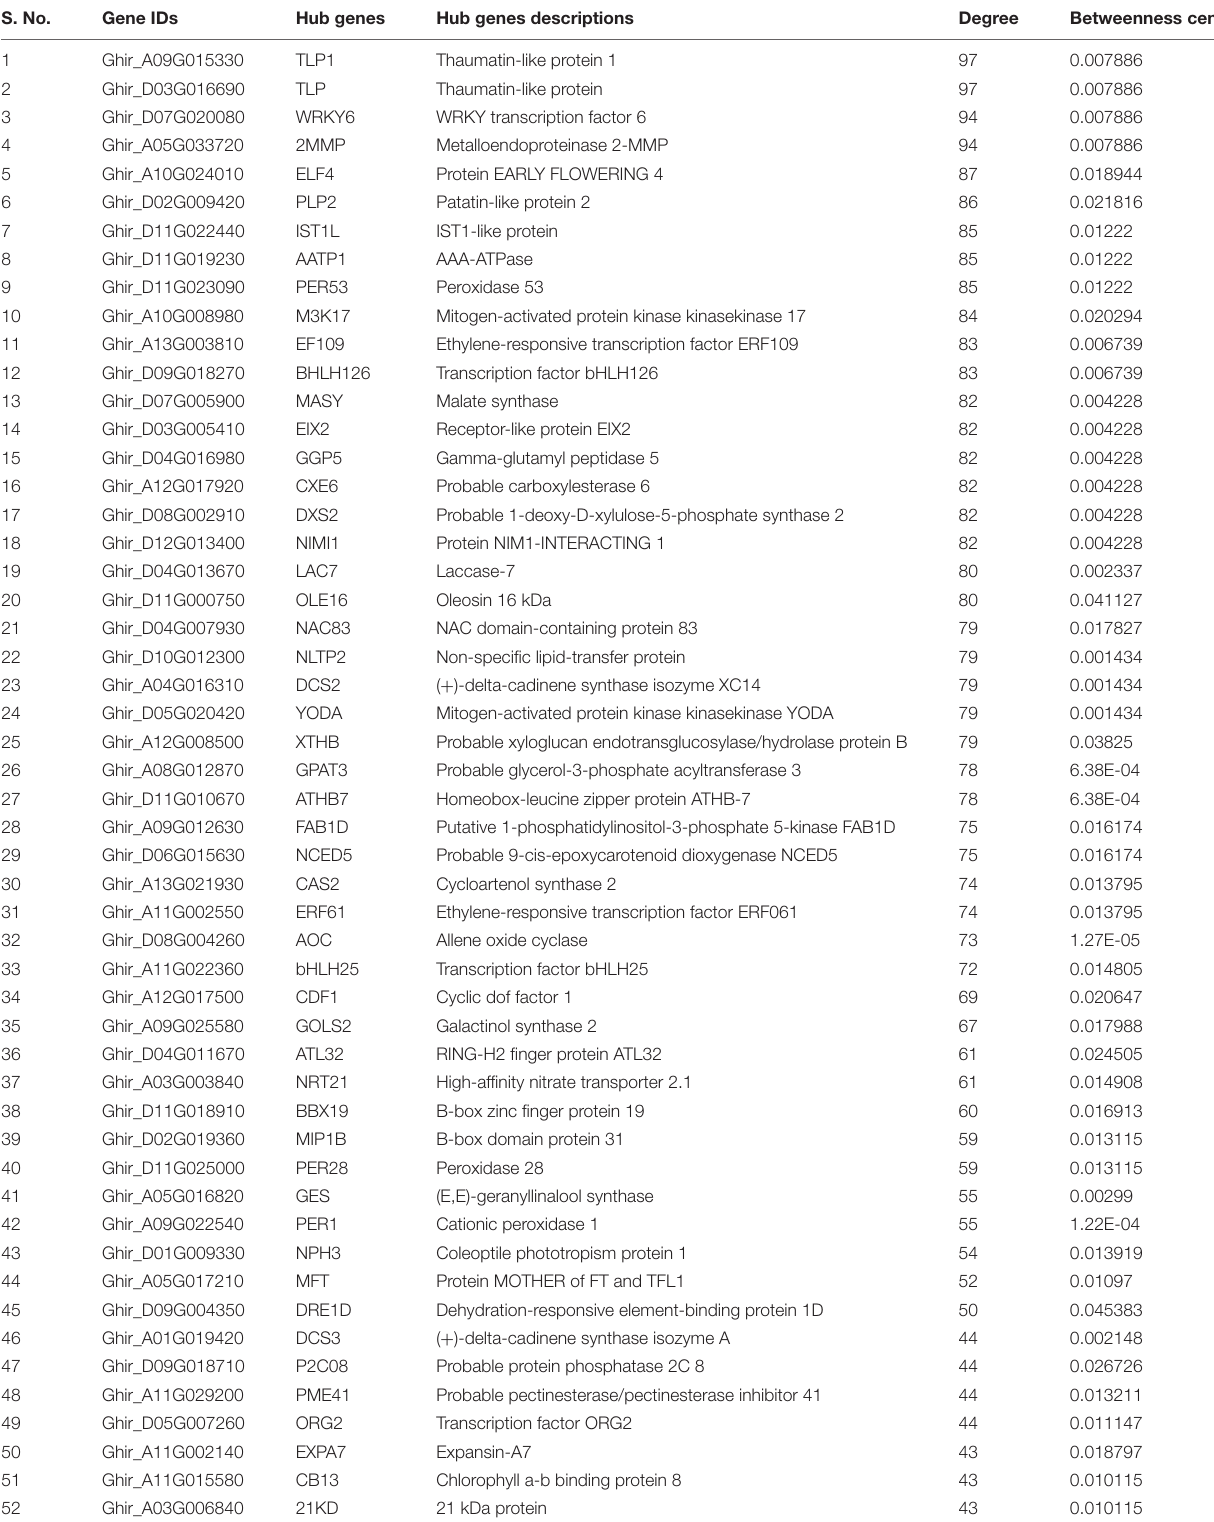
TABLE 1B | Top 61 hub genes based on the topological properties in co-expression network of DEGs in salt stress condition, and arranged on the basis of the decreasing degree of connectivity value. S. No. Gene IDs Hub